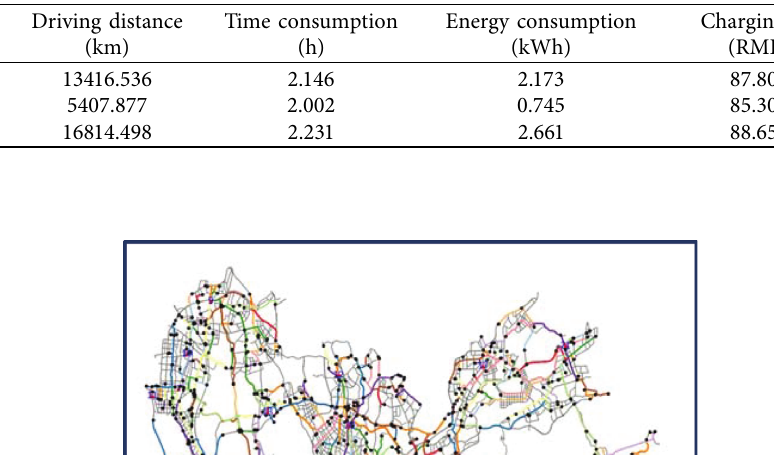
Table 5: Cost of the paths to three charging stations.